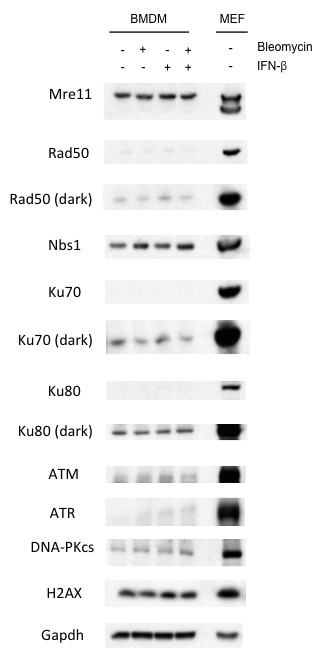
Type I IFN does not impact expression of key DDR factors.Western blotting for Mre11, Nbs1, Rad50, Ku70, Ku80, ATM, ATR, DNA-PKcs, and H2AX in untreated (-) WT mouse embryonic fibroblasts (MEFs) or BMDMs after no stimulation (-) or stimulation (+) with IFN-β (100 U/mL), bleomycin (1 ug/mL), or bleomycin + IFN-β for 6 hr. GAPDH is used as a protein loading control. Data are representative of three independent experiments.